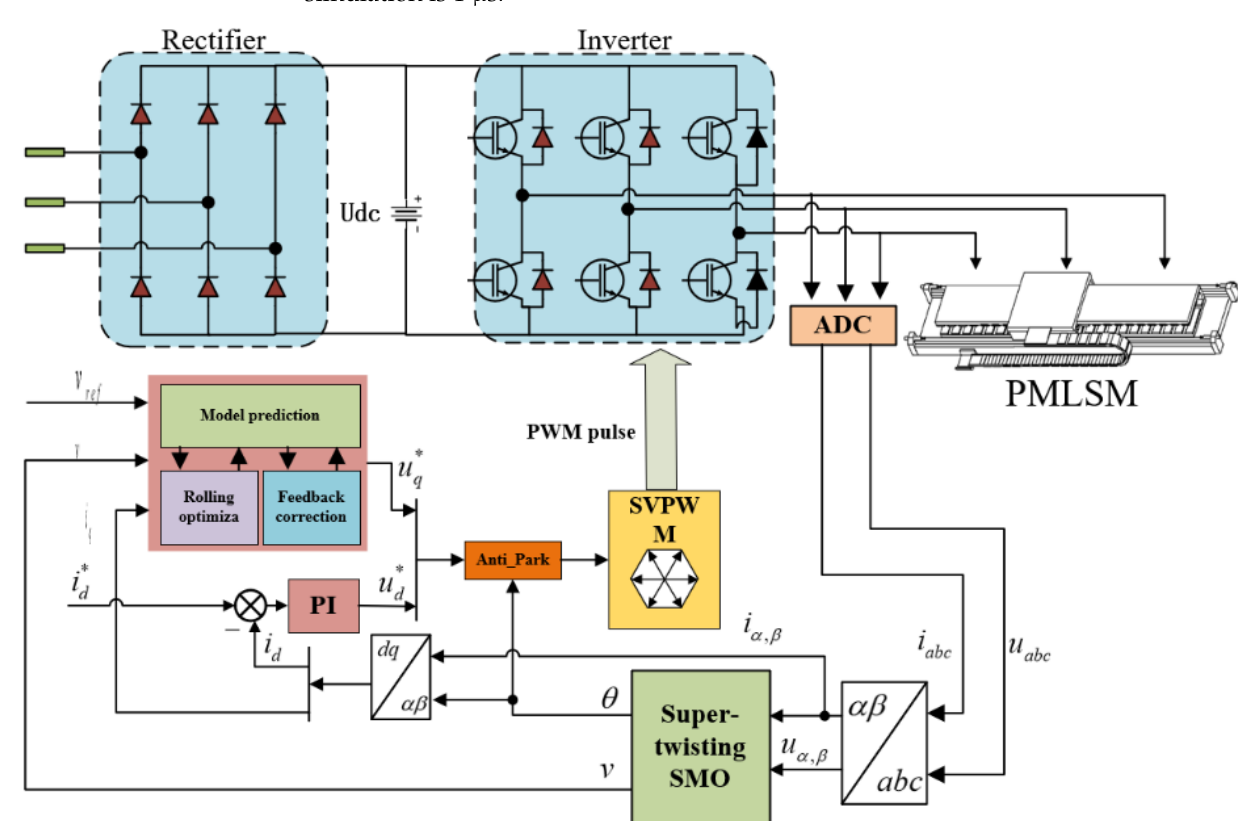
Figure 5. Control system